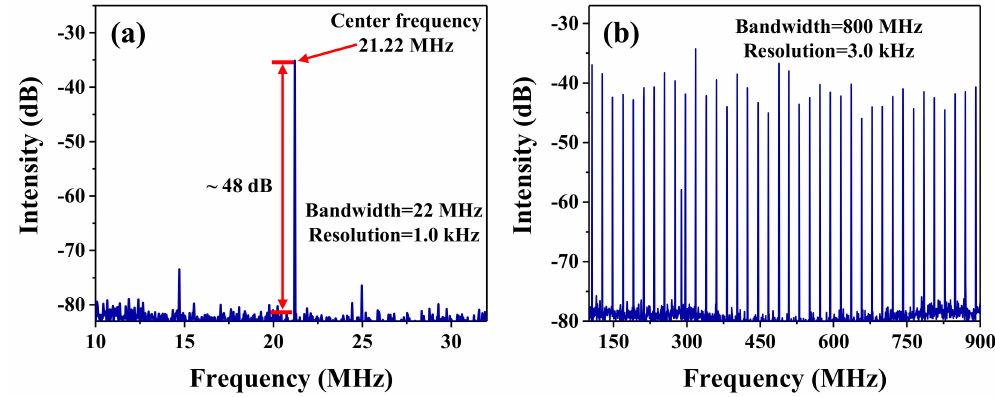
Figure 6. ( a ) The RF output spectrum of the mode-locking laser with the fundamental frequency of 21.22 MHz. ( b ) The RF spectra with a band width of a 800 MHz